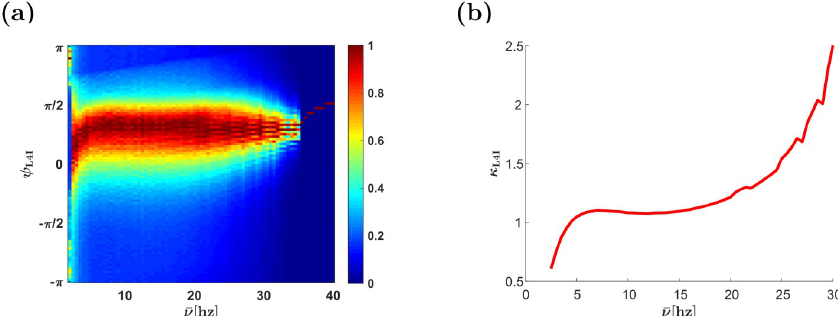
Fig 6. Effects of whisking frequency. (a) The (non-normalized) distribution of L4I neuron phases, κ L4I , is depicted by color as a function, � n ¼ n = ð 2 p Þ . (b) The width of the distribution, κ L4I , of L4I neurons is shown as a function of � n . The parameters used in these graphs were: κ VPM = 1, ψ VPM = 5 π /6 γ = 0.9, D = 10hz, and d = 3ms. We used the temporally asymmetric exponential learning rule, Eq (9), with τ − = 50ms, τ + = 22ms, μ = 0.01, α = 1.1, and λ = 0.01.